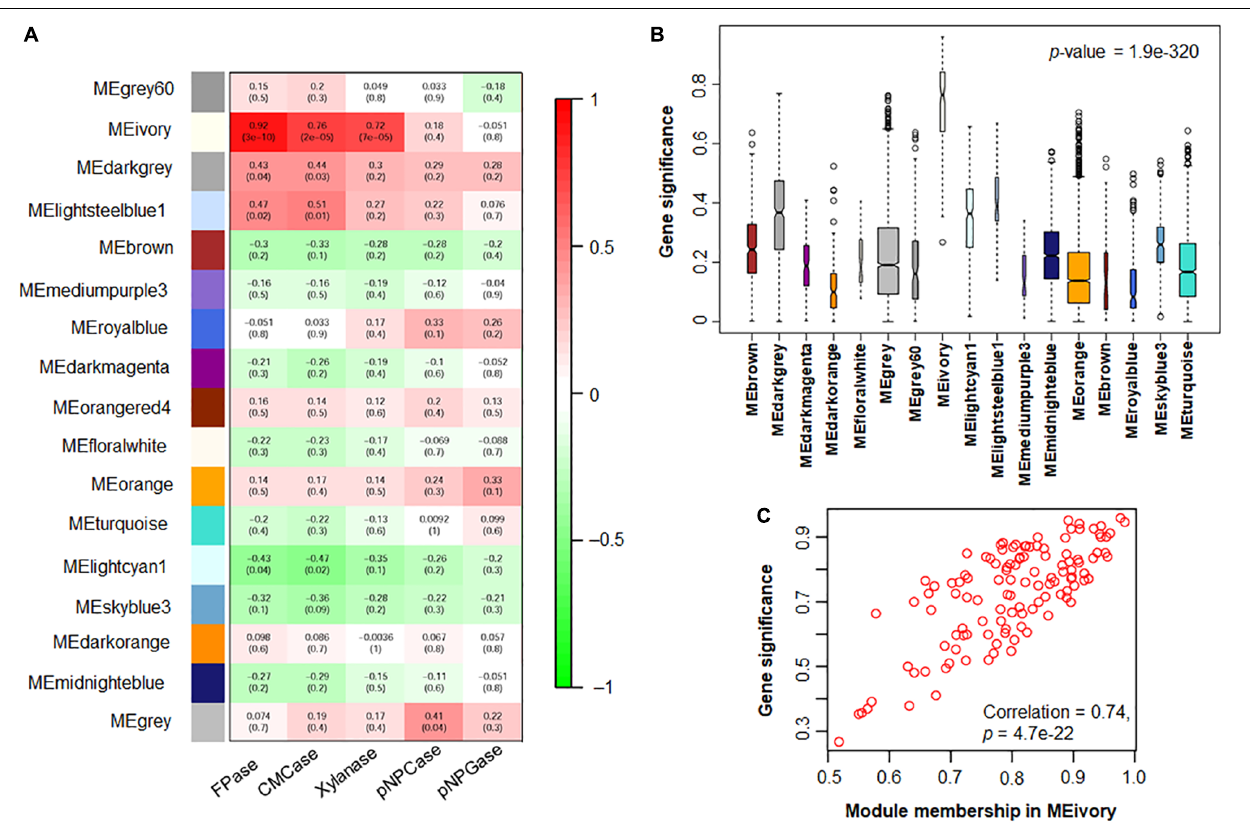
FIGURE 9 | Module and trait correlations. (A) Modules and cellulase and xylanase production associations. The rows and columns correspond to module eigengenes and enzyme production levels, respectively. Each cell indicates the correlation coefficient and p -value between the module and specific enzyme production level. (B) Heatmap plot of mean gene significances across modules. (C) Gene significance vs. module membership in MEivory, which correlated the most with traits in panel (A)